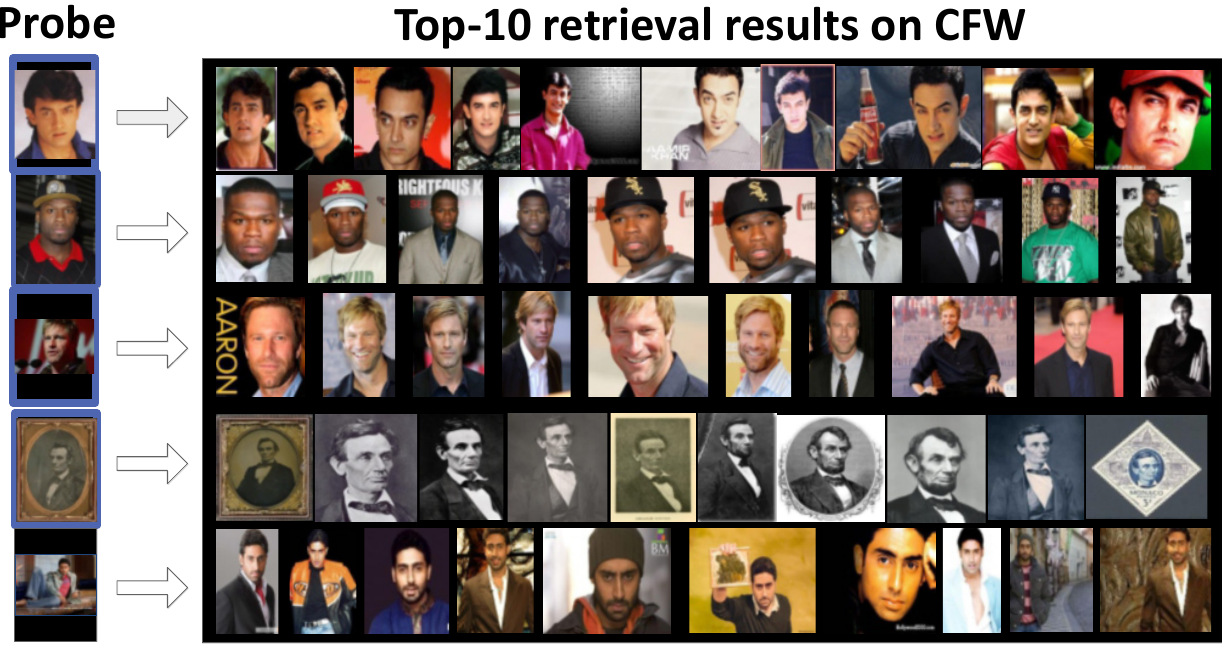
Fig. 7 Top-10 retrieval results for five probes using CFW.